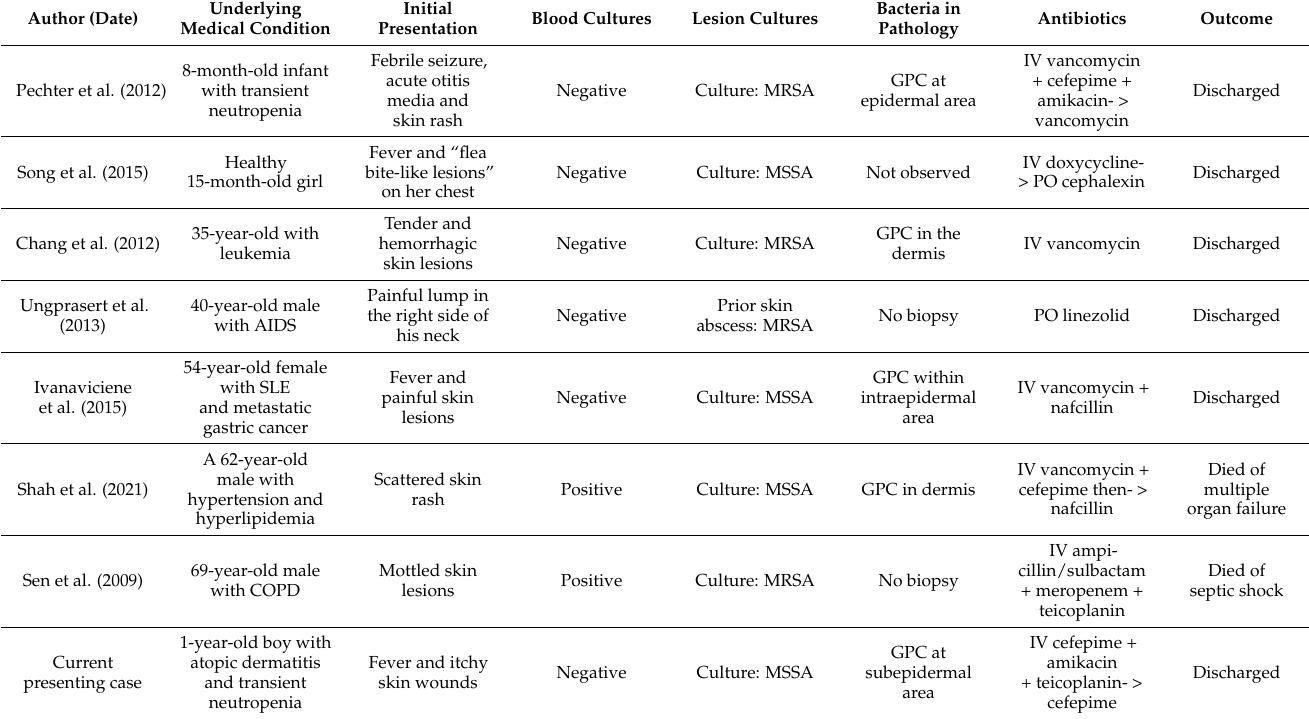
Table 1. Case reports of patients with Staphylococcus aureus ecthyma